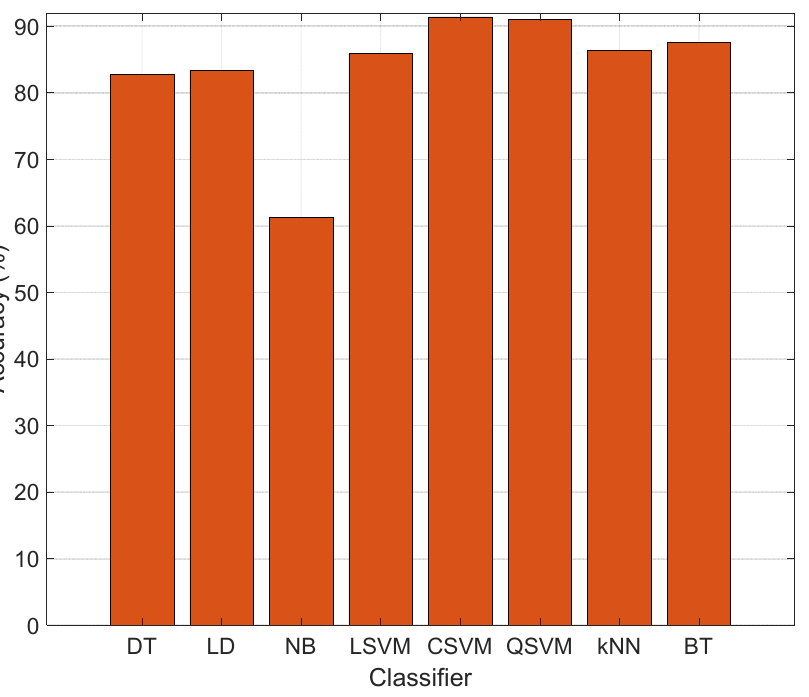
Figure 7. Classification accuracies of the classifier. Here, the presented L-tetrolet and maximum pooling-based feature generation method is applied to Case 3. The first and second layers of the TSRFINCA are applied to these features to eliminate the redundant feature, and NCA selected 1000 features for tests. Figure 6 demonstrates that the best classifier is CSVM. Therefore, CSVM is selected as both an error generator and a classifier.